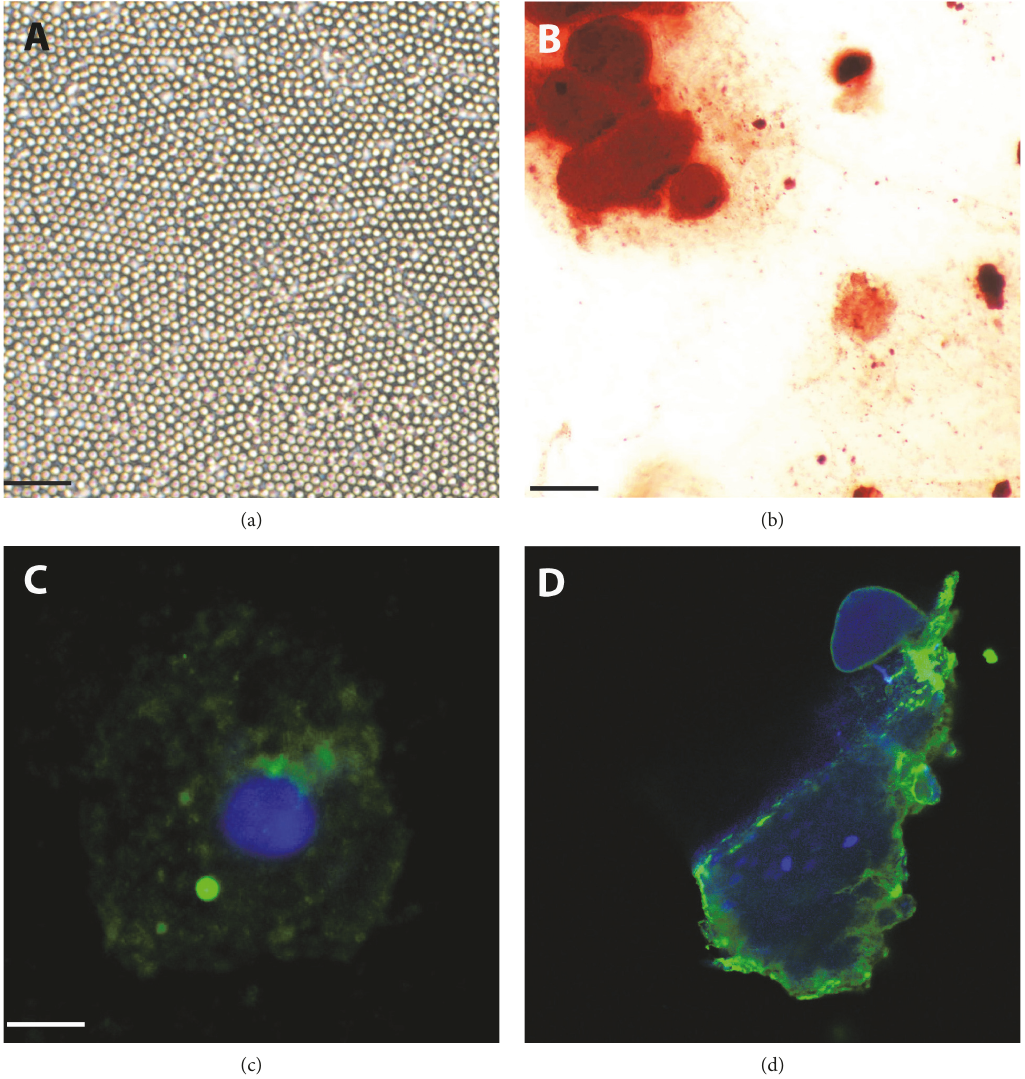
Figure 1: Blood derived stem cells ’ (BDSCs) osteogenic di ff erentiation with rapamycin. (a) BDSCs before starting the di ff erentiation protocol. The cells show typical morphological features of stemness such as small size, roundish shape, and, in vitro, a disposition to a “ string of pearls ” appearance. (b) Alizarin Red S staining on BDSCs after 10 days of osteogenic di ff erentiation, to evaluate inorganic calcium phosphate deposition. (c) Visualization by immuno fl uorescence analysis through confocal microscopy of a single di ff erentiated cell (60x). (d) Image from three-dimensional stack analysis by confocal microscopy of blood-derived stem cells after ten days of osteogenic di ff erentiation (in green, osteocalcin; in blue, DAPI: merged; (a), (b) 100 μ m, (c) bar =8 μ